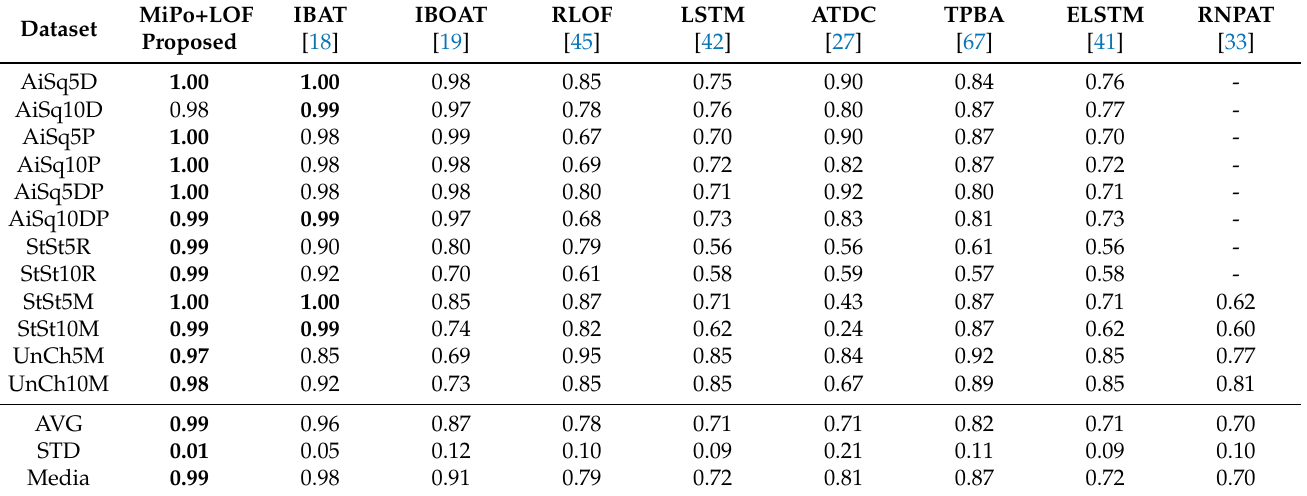
Table 2. AUC results of trajectory outlier detectors and proposed methods (the best per row is